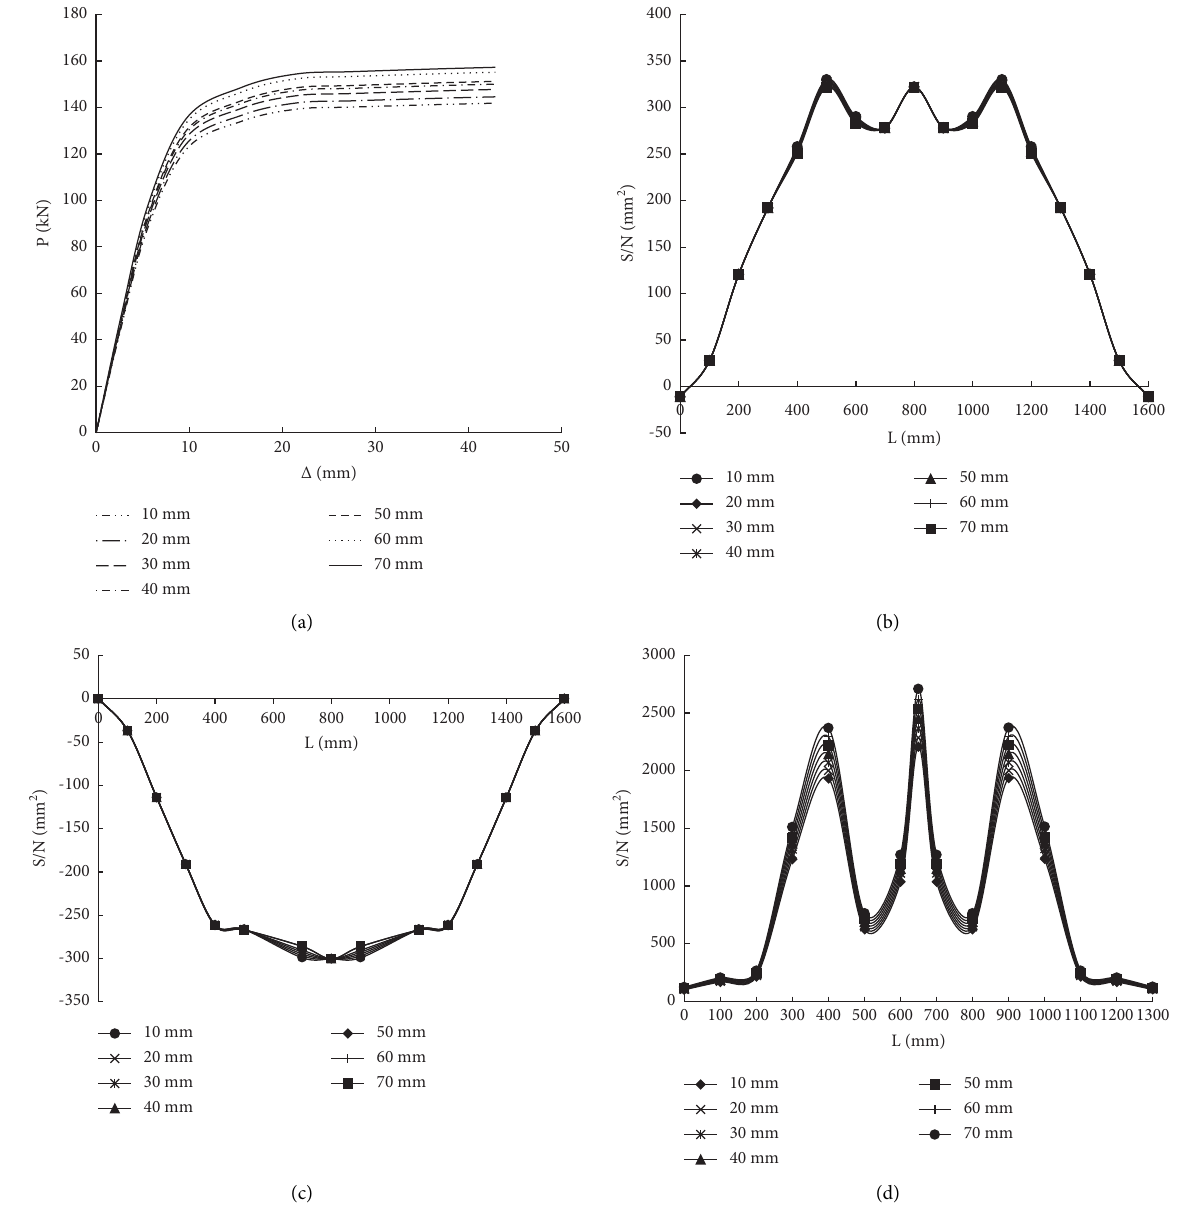
Figure 19: Effect of CFRP sheet’s width. (a) Load and deflection. (b) Stress along steel beam length. (c) Stress along steel beam width. (d) Stress along CFRP sheet’s